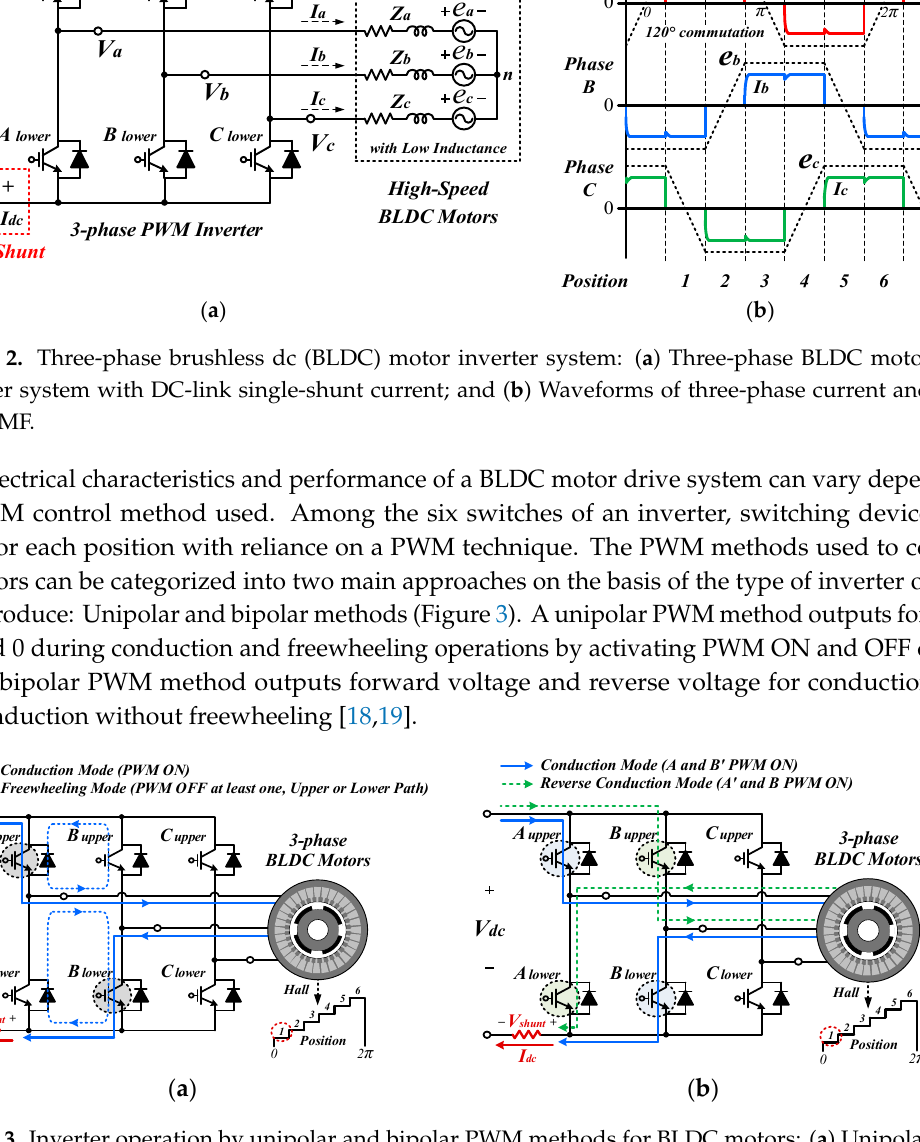
Figure 1. Control strategy using hybrid pulse width modulation (PWM) method according to operation region.